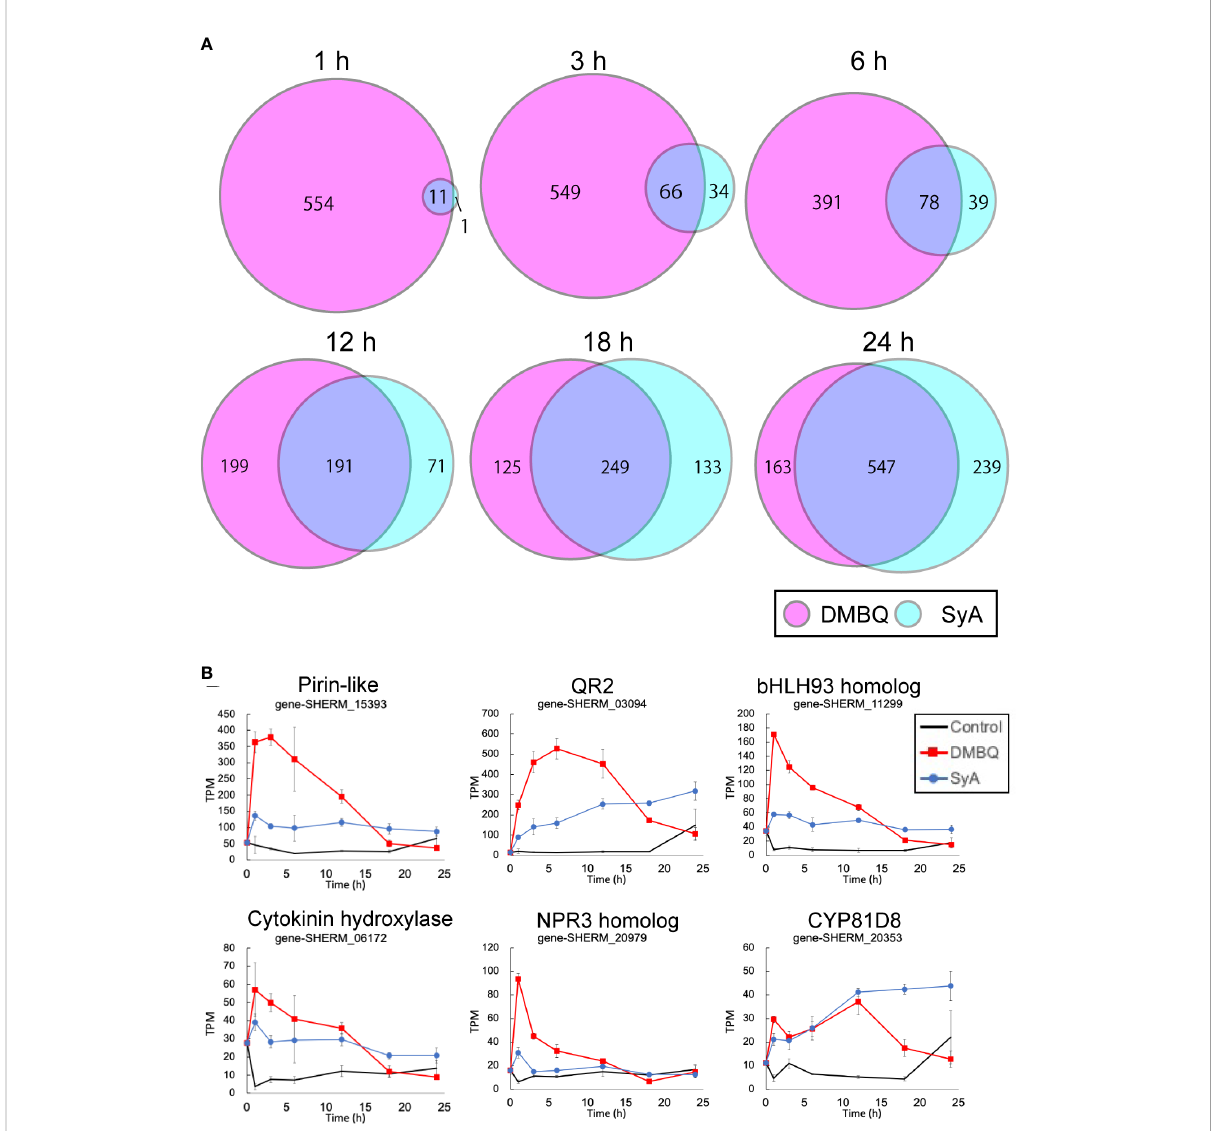
FIGURE 4 Number of transcripts upregulated at each time point after DMBQ or SyA treatments. (A) Venn diagrams show the number of transcripts (contigs) upregulated by DMBQ or SyA treatment at each time point. Differentially expressed genes were selected by edgeR based on the comparison of HIF treatment with water control. (B) Expression patterns of early core signaling genes at 1, 3, 6, 12, 18 and 24 h after